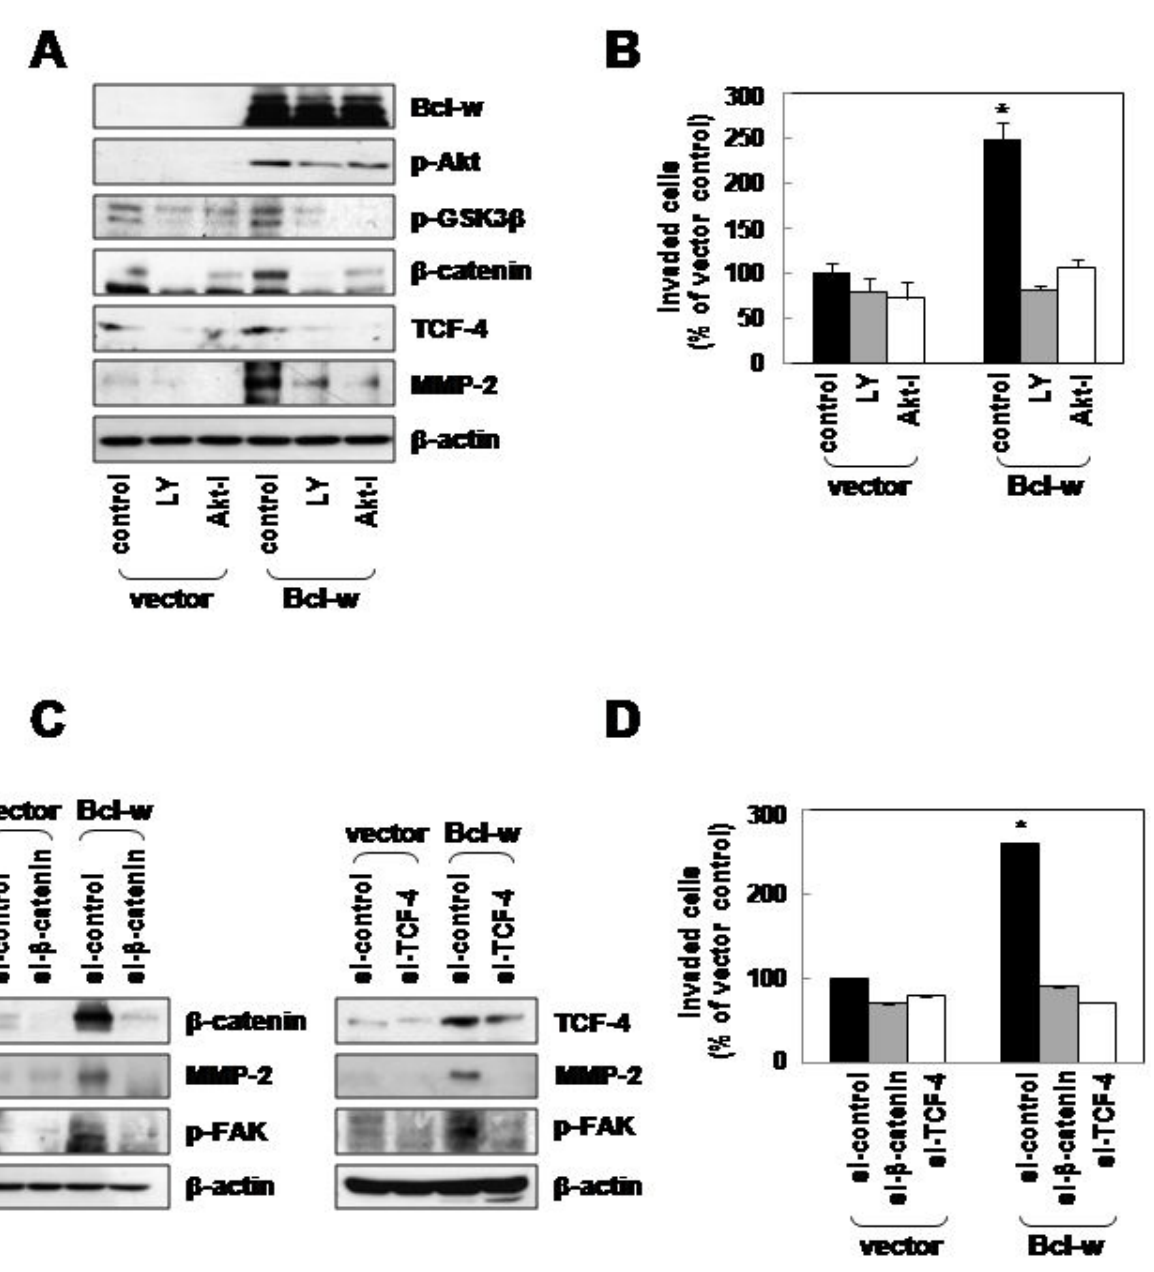
Figure 5. Bcl-w-induced β-catenin signaling components promote invasive potential via activation of the PI3K-Akt pathway. A , the indicated U251 cell transfectants were incubated in serum-free medium in the presence or absence of PI3K inhibitor (LY294002 (LY); 10 µmol/L) or Akt inhibitor (Akt-I; 10 µmol/L) for 1 hour. Expression levels and activities of p-Akt, p-GSK3β, β-catenin, TCF-4 and MMP-2 proteins were compared using Western blotting. B , cells treated with PI3K inhibitor or Akt inhibitor in the lower compartments of the invasion chambers for 24 hours, respectively. Invasive potential of treated cells was compared. *, p< 0.05 versus untreated control, n = 5. C , β-catenin and TCF-4 siRNAs (20nM) were introduced into vector or Bcl-w overexpressing cells, and cellular levels of β-catenin, TCF-4, MMP-2 and p-FAK compared after 24 hours of incubation using Western blotting with β-actin as a loading control. D , invasive potential of the indicated transfectants was compared. *, p< 0.05, n = 5.